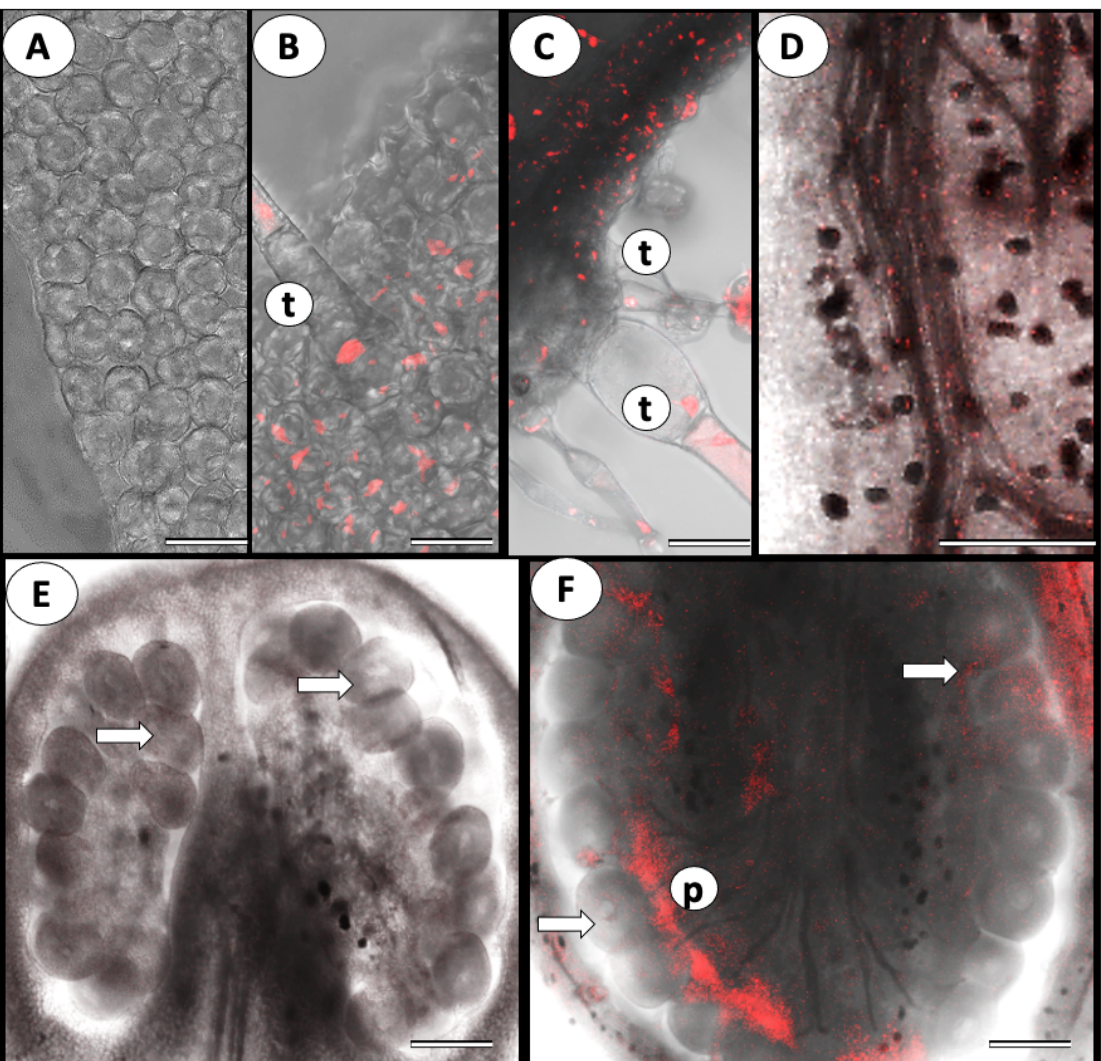
Figure 2. Representative confocal microphotographs of ToBRFV presence in the vegetative and reproductive organs of tomato. In situ hybridization with a specific ToBRFV DNA probe fluorescently labeled with Cy3. Intact uninfected plants served as control. ( A ) Leaf surface in control plant, Bar = 50 µ m; ( B ) Leaf surface in infected plant. Note numerous red dots (fluorescent signal) in the epidermal cell and trichomes (t), Bar = 50 µ m; ( C ) Transverse section of the infected leaf. The signal is visible in all leaf tissues and trichomes (t), Bar = 100 µ m; ( D ) Section of the sepals of infected plant; note fluorescent signal (small red dots), Bar = 200 µ m; ( E ) Cross-section of the control uninfected ovary; ovules (arrows) are visible, Bar = 200 µ m. ( F ) Cross-section of the infected ovary; ovules (arrows) are not infected, but ovary walls, pericarp, and placental tissues (p) show fluorescence signal of virus infection. Bar = 200 µm.